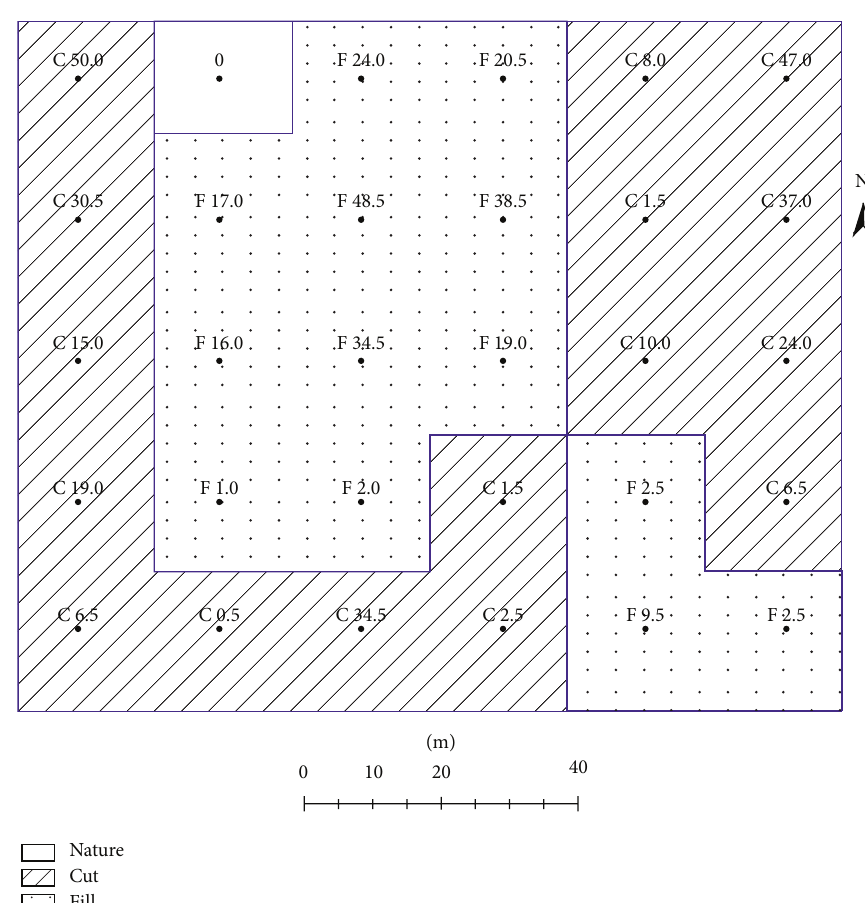
Figure 1: The grids of cuts or fills of the study area for land leveling (the unit of cut or fill depth in each grid is in centimeter).